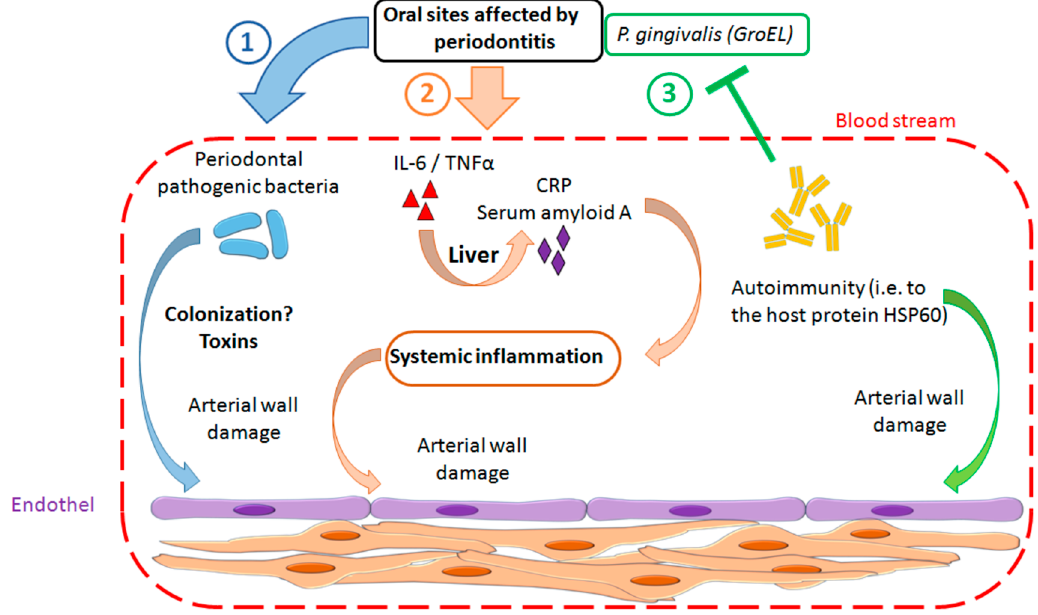
Figure 2. Potential pathomechanism that may be involved in the association of PD and PAOD; (1) periodontal pathogenic bacteria enter the bloodstream, invade and damage the arterial wall; (2) release of inflammatory mediators into the bloodstream, such as serum amyloid A, interleukin-6 (IL-6), tumor necrosis factor α (TNF α ), and C-reactive protein (CRP) causing a systemic inflammation that also damages the arterial wall; (3) autoimmunity to host proteins (i.e., heat shock protein 60, HSP60) resulting from the host immuno response to the bacterial proteins, such as the HSP60 homolog GroEL.